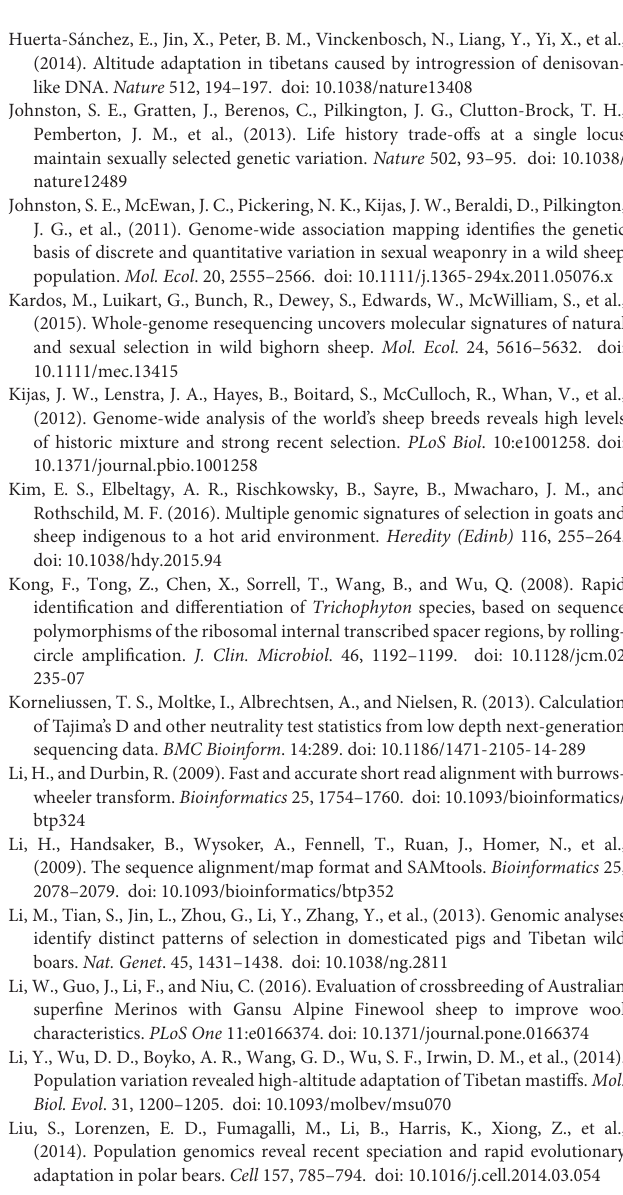
Supplementary Figure 2 | Genotype frequency of candidate genes in different breeds. Supplementary Figure 3 | Genes embedded in artificial selected regions in fine-wool sheep related to horn traits. Supplementary Figure 4 | Eight horned alpine merino sheep samples (high altitude) and 8 horned Chinese merino sheep (low altitude) form a group as a horn group to analyze adaption. Supplementary Figure 5 | Eight polled alpine merino sheep samples (high altitude) and 8 polled Chinese merino sheep (low altitude) form a group as a horn group to analyze adaption. Supplementary Figure 6 | Intra-species comparison of horn and polled alpine merino sheep.